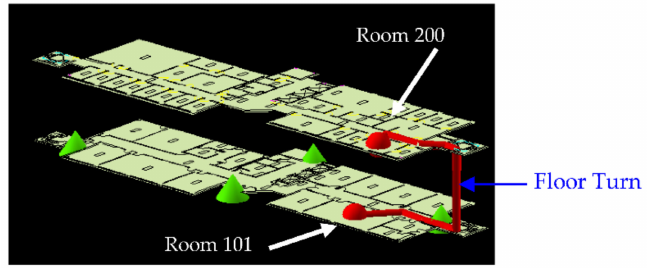
Figure 3. Floor turn representation.